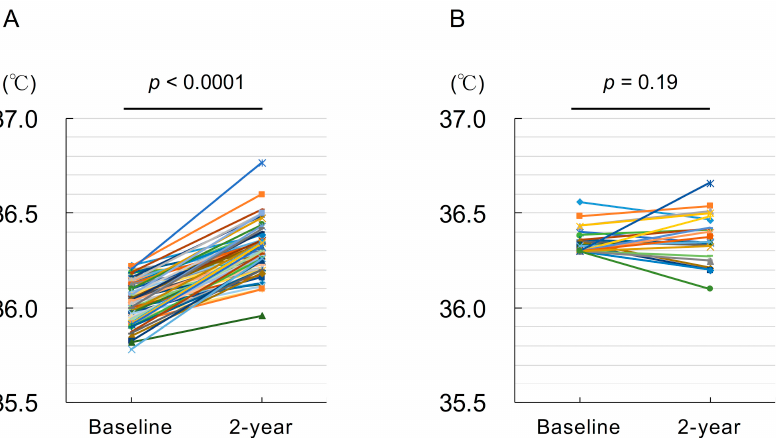
Figure 2. Change in body temperature after exercise training. Lower body temperature group ( A ) and normal body temperature group ( B ).